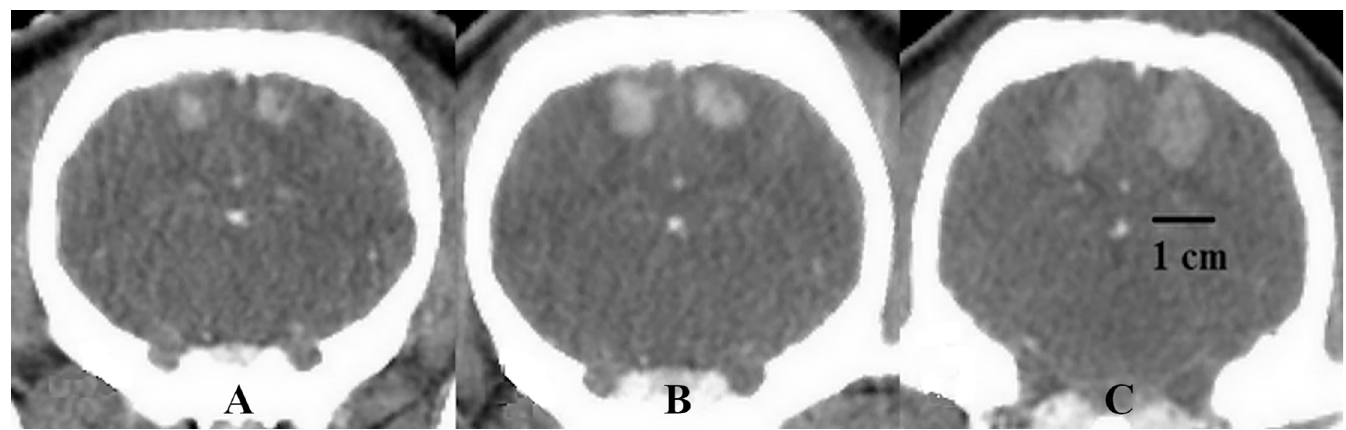
Fig 2. U87 GB tumor growth over time. A) Tumor size approximately 3 mm, 7 days after implantation, (B) tumor size approximately 7 mm, 10 days after implantation, (C) tumor size approximately 13 mm, 14 days after implantation, before 165 Ho injection.